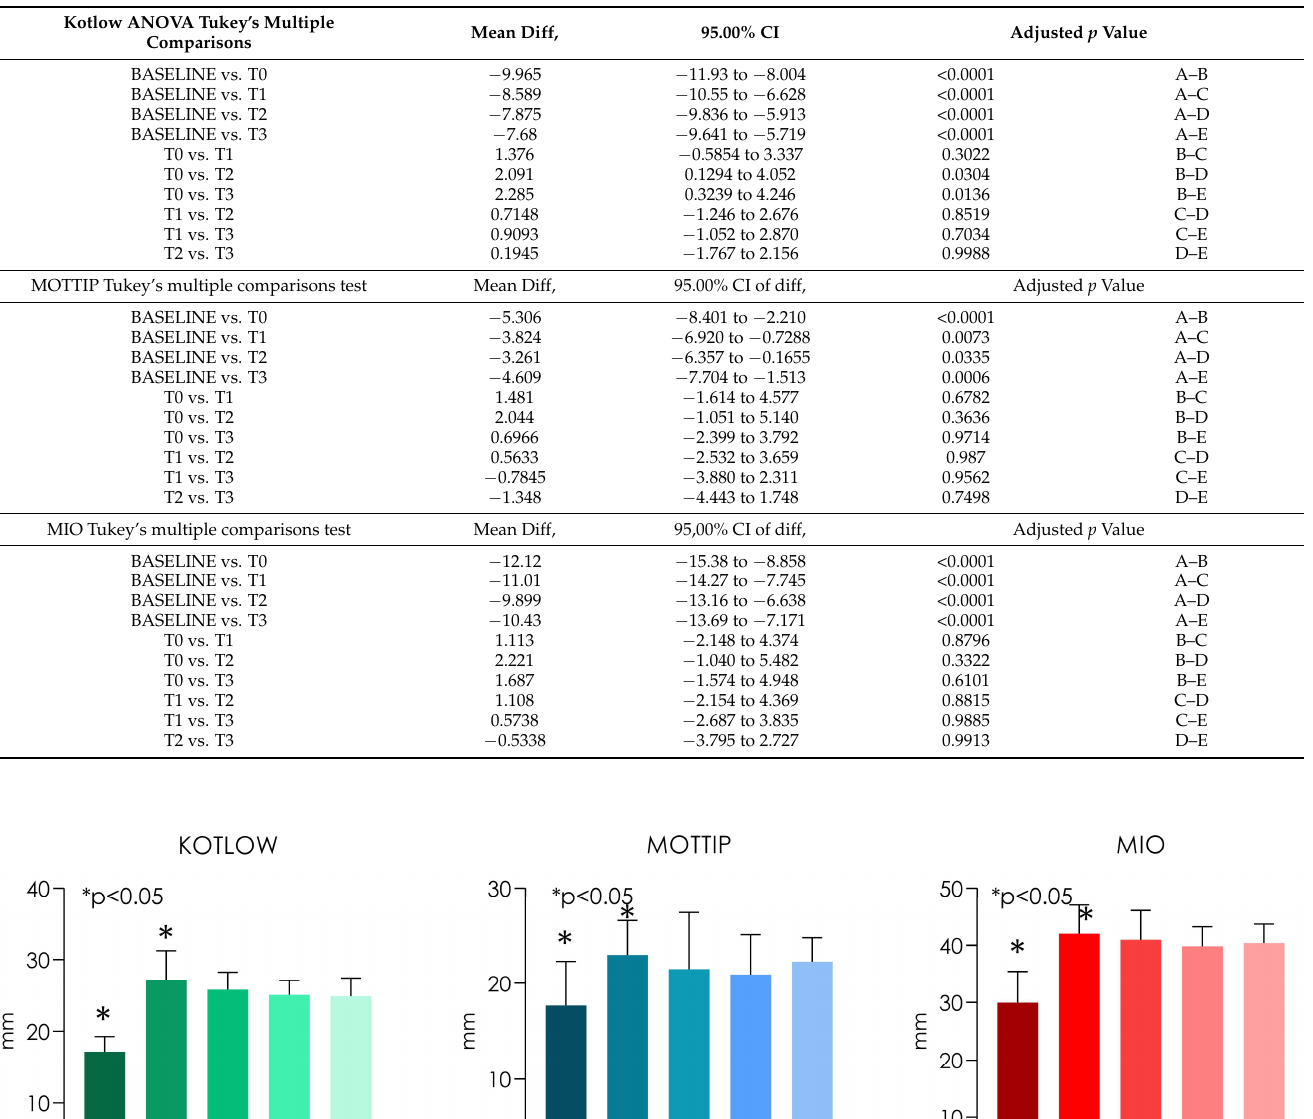
Table 3. Summary of the One-Way ANOVA Tukey’s multiple comparisons post hoc test.